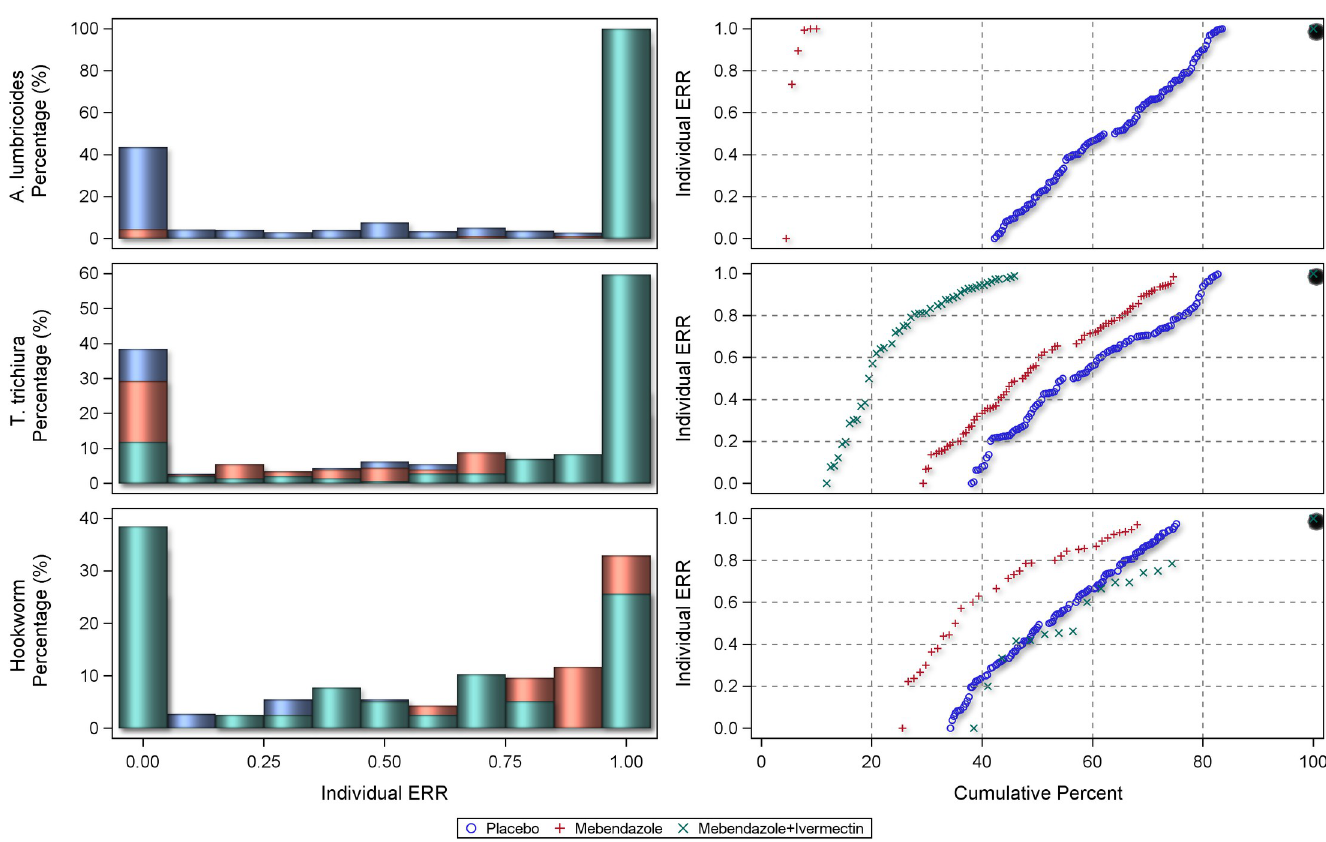
Fig 12. Distribution of individual responses in studies of 22–45 days follow-up for Ascaris lumbricoides , Trichuris trichiura and hookworm for mebendazole and mebendazole combinations. The right-hand plots show the proportions of people at a given ERR with colours related to placebo or a drug. The left-hand plots show cumulative distribution of ERR in people treated with a drug from 0 to